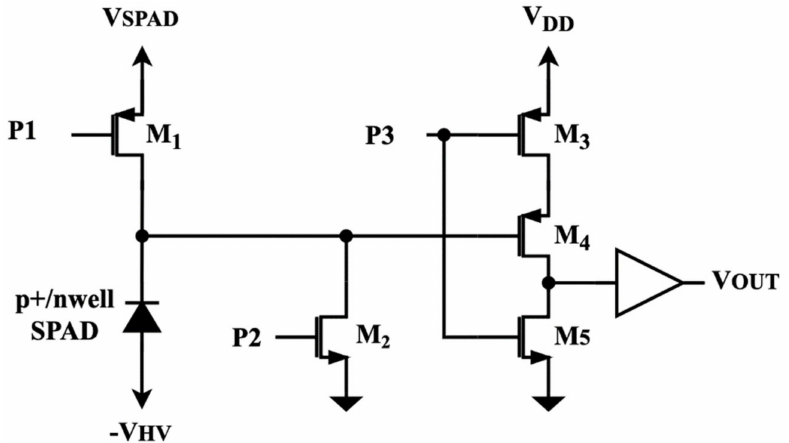
Figure 4. Schematic of the time-gated SPAD pixel.